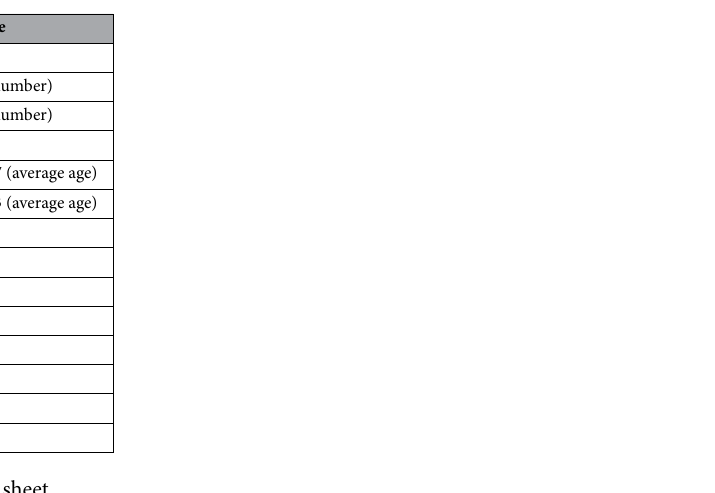
Table 1. Patient information